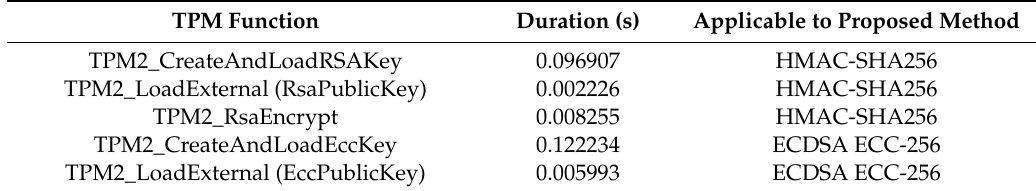
Table 2. Measurements of the executed TPM functions done in a secure environment by a third party.